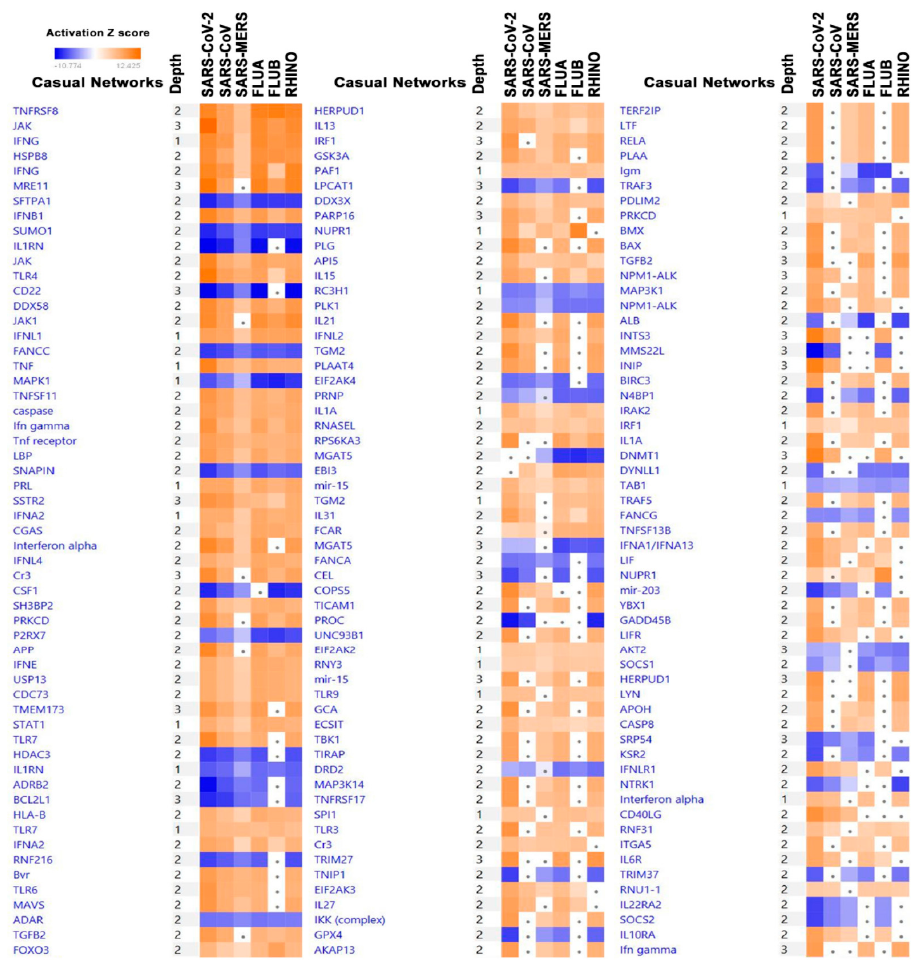
Figure 4. Significantly affected casual networks based on differentially expressed genes in the indicted treatment group (SARS-CoV-2, SARS-CoV, SARS-MERS, FLUA, FLUB, and RHINO) in Calu-3 cells. Di ff erentially expressed genes from the six virally infected Calu-3 cells were subjected to casual network analysis in IPA. Activation Z score is depicted according to the color scale (2.0 ≤ Z score ≤ − 2.0). Red indicates activation, while blue indicates suppression. Squares with a filled circle denote canonical with an activation Z score <